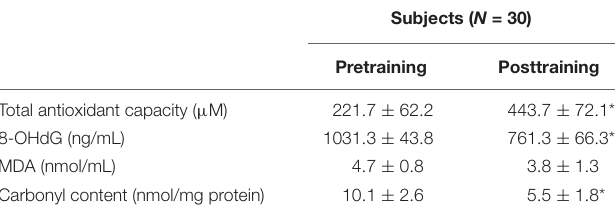
TABLE 3 | The oxidative stress markers at